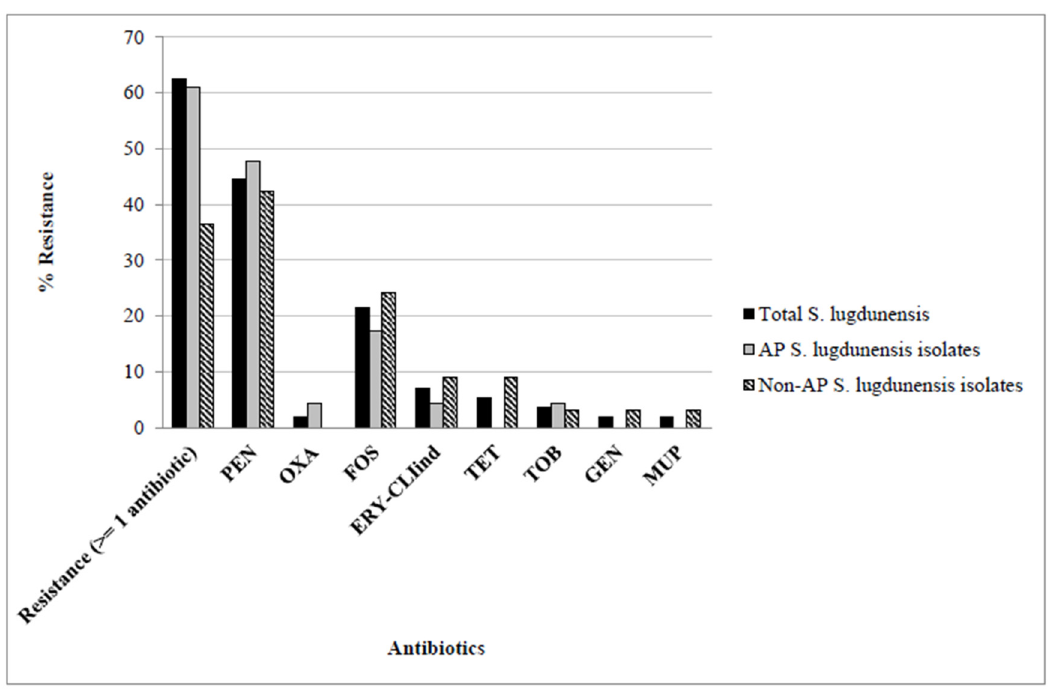
Figure 3. Antimicrobial resistance phenotype of the 56 S. lugdunensis isolates versus the 23 AP and the 33 non-AP S. lugdunensis isolates. Abbreviations: PEN, penicillin; OXA, oxacillin; FOS, Fosfomycin; ERY-CLIind, erythromycin-clindamycin inducible; TET, tetracycline; TOB, tobramycin; GEN, gentamycin; MUP, mupirocin. Non-statistically significant differences ( p ≤ 0.05) were observed. Table 4. Origin, type of sample, antimicrobial resistance phenotype/genotype and bacteriocin genes of the 23 AP isolates based on the antimicrobial activity